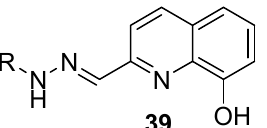
Figure 3. A representative structure of substituted 2-hydrazino-8-hydroxyquinolines.